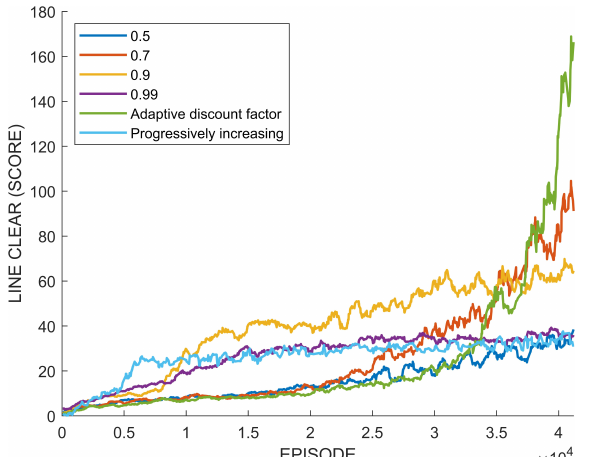
Figure 8. Performance comparison between fixed and adaptive discount factor in Tetris.